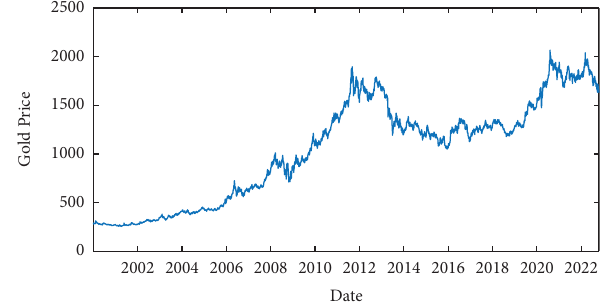
Figure 1: Daily international gold price curve (January